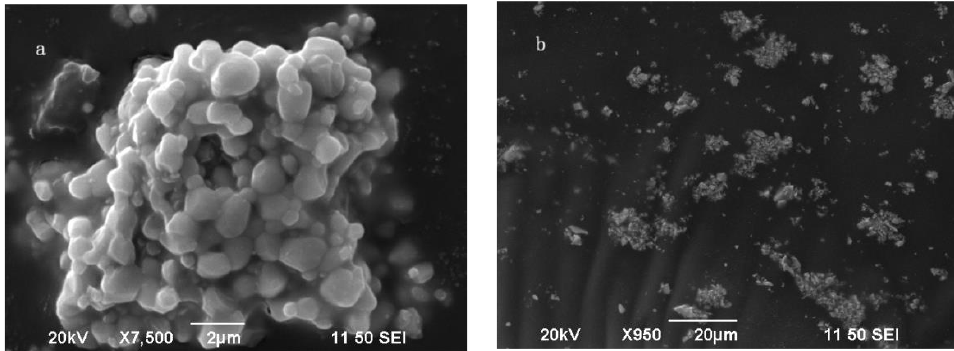
Figure 6. SEM of Sr 0.99 Mo 0.5 W 0.5 O 4 :Eu 3+ . ( a ) 7500 times; ( b ) 950